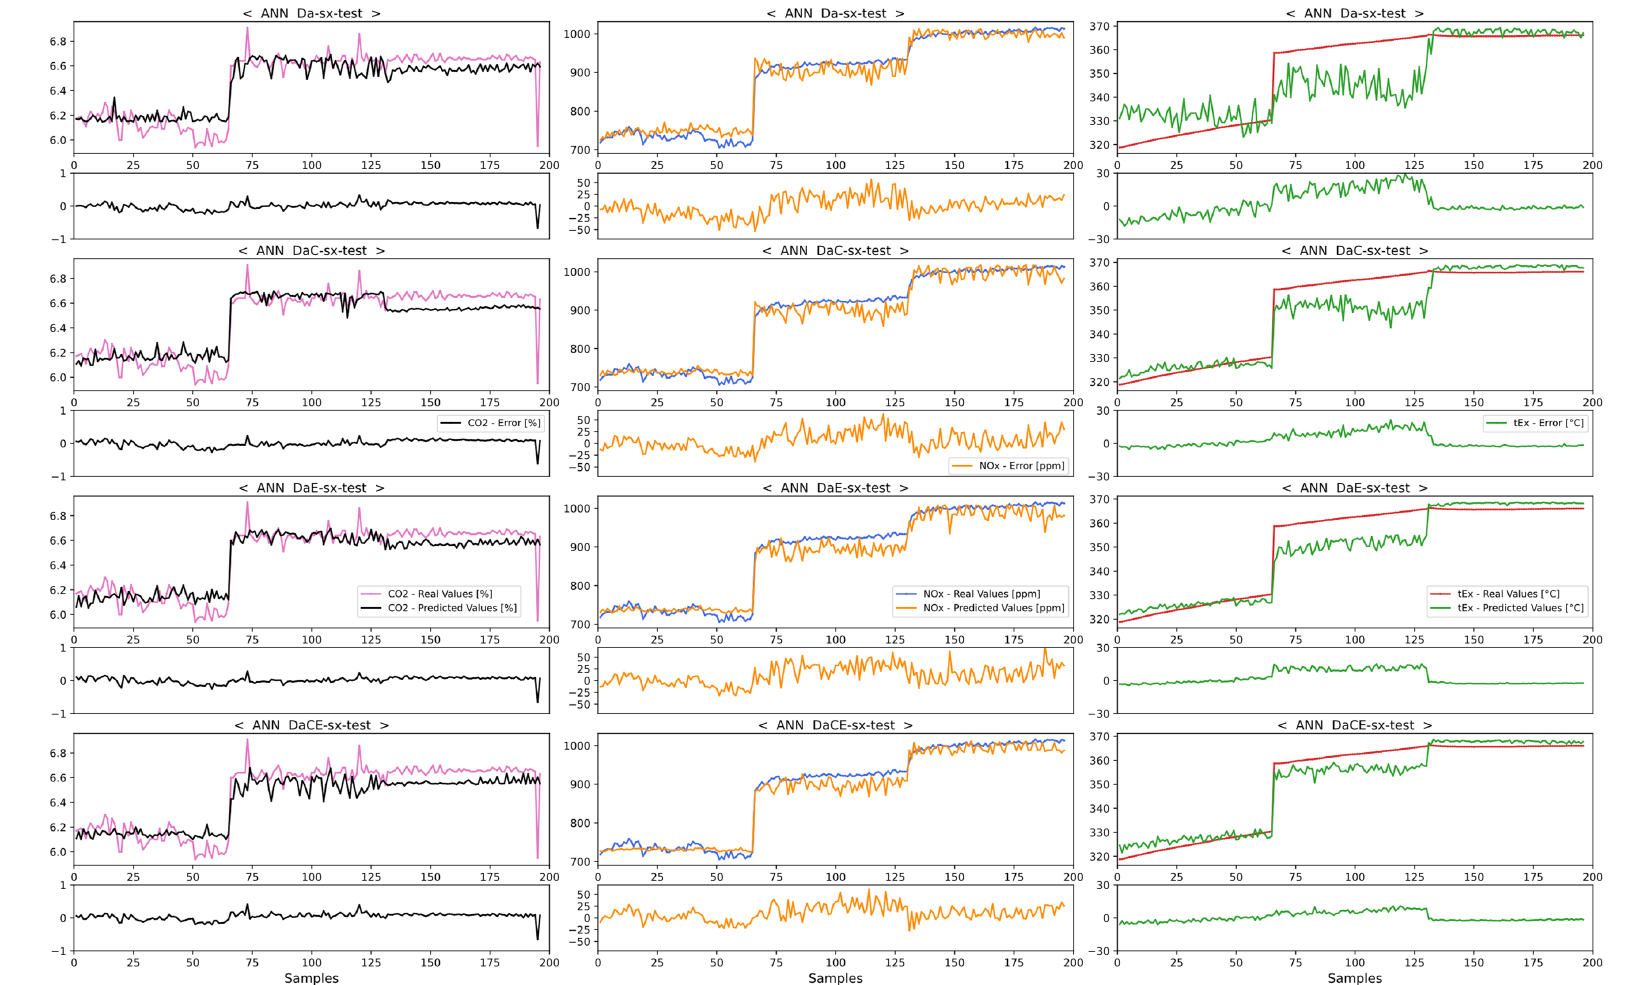
Figure 10. Comparison of real and predicted values for different datasets with ANN models in no ‐ SCR mode.